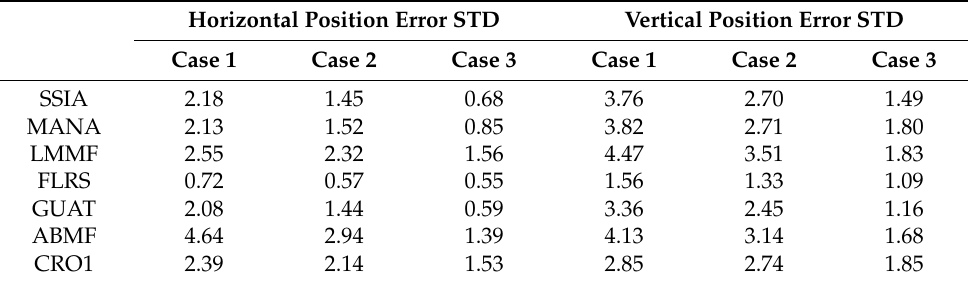
Table 4. One month STD of horizontal and vertical positioning errors in March 2015.